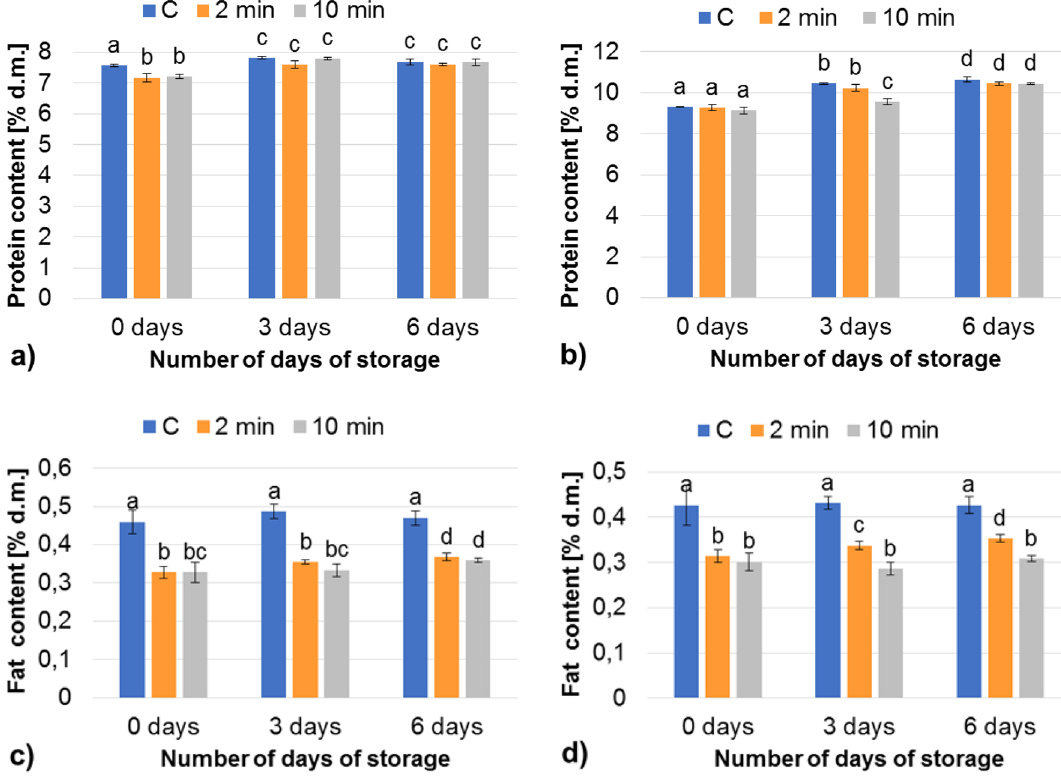
Figure 3. Protein ( a , b ) and fat ( c , d ) content of bread, ( a , c ) gluten-free bread, ( b , d ) mixed wheat-rye bread; mean values in the same figure marked with different letters are significantly (α = 0.05)